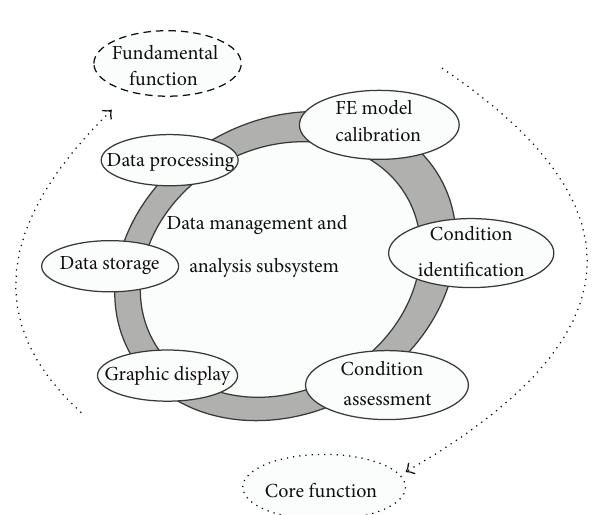
Figure 4: The structure of WSHMS of RYRB.